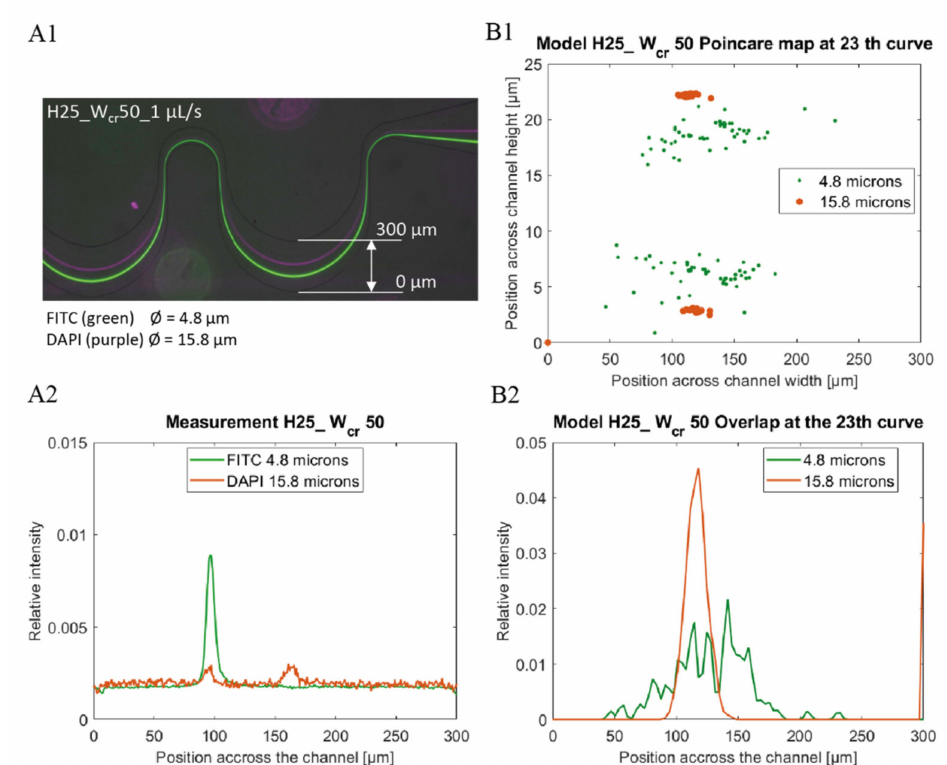
Figure 3. Comparison of Experimental ( A ) and Computational ( B ) data of fluorescent bead’s lateral focusing at 1 µ L/s flow rate in channel H25_C50. The lateral distribution of 4.8 µ m (green) and 15.8 µ m (purple) beads are well separable in the 300 µ m channel width ( A1 ) and were represented based on the beads ’fluorescence intensity, and lateral position in channel width ( A2 ). In the finite element simulation, the same bead distributions were examined in the channel cross section ( B1 ), and in the channel width ( B2 ) based on focusing